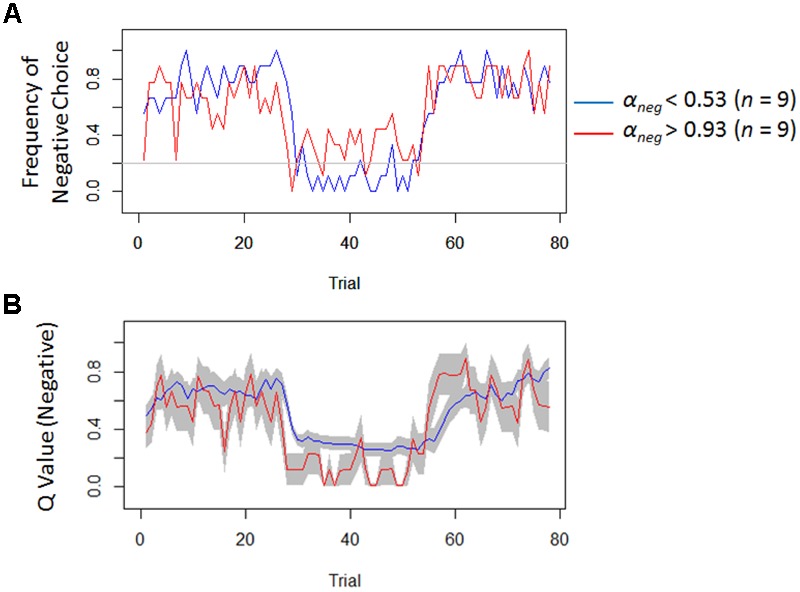
Frequency of negative choice and average outcome predictions of negative self-reference in Study 2. (A) Presents the average choice frequencies of negative self-reference for individuals from the upper (red) and lower quartiles (blue) of the learning rate of negative self-reference (i.e., αneg). (B) Shows the outcome predictions of negative self-reference (Qneg) for the same individuals (standard errors are shown in the gray field).